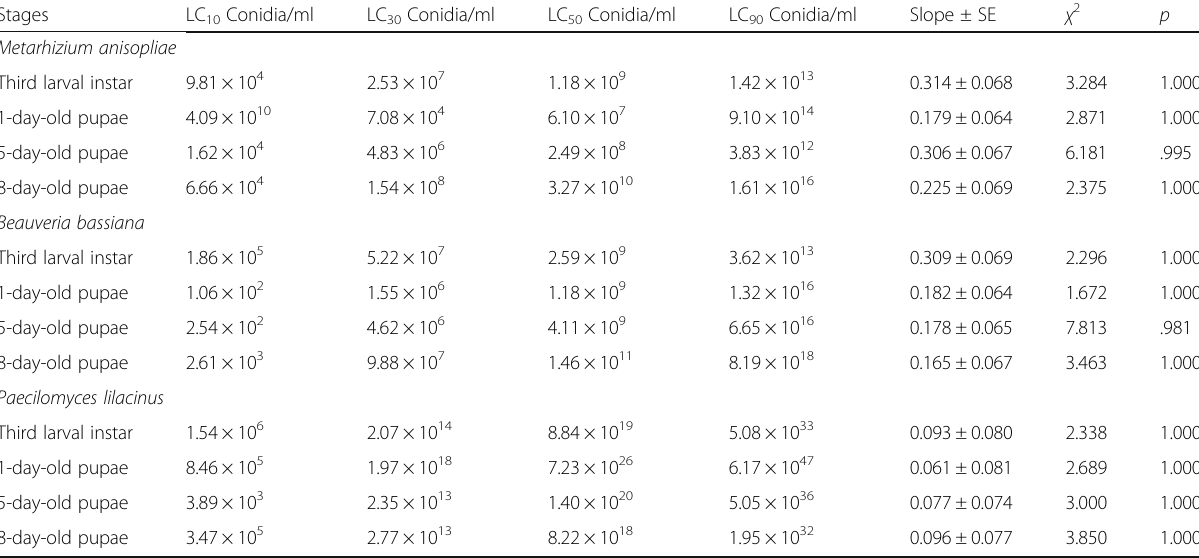
Table 2 Toxicity of Metarhizium anisopliae, Beauveria bassiana and Paecilomyces lilacinus to different stages of Ceratitis capitata